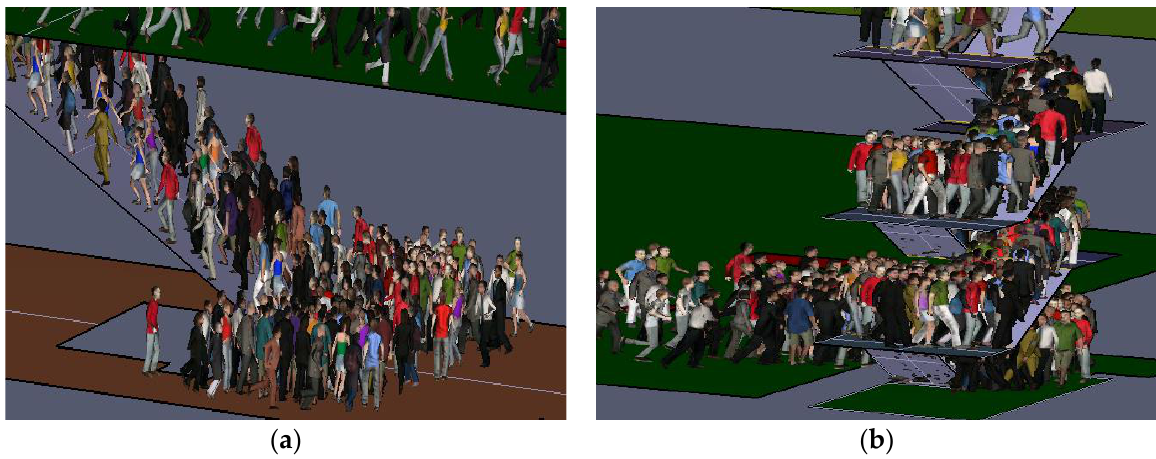
Figure 13. ( a ) Evacuation in platform 5 ; ( b ) Evacuation in Station hall floor.